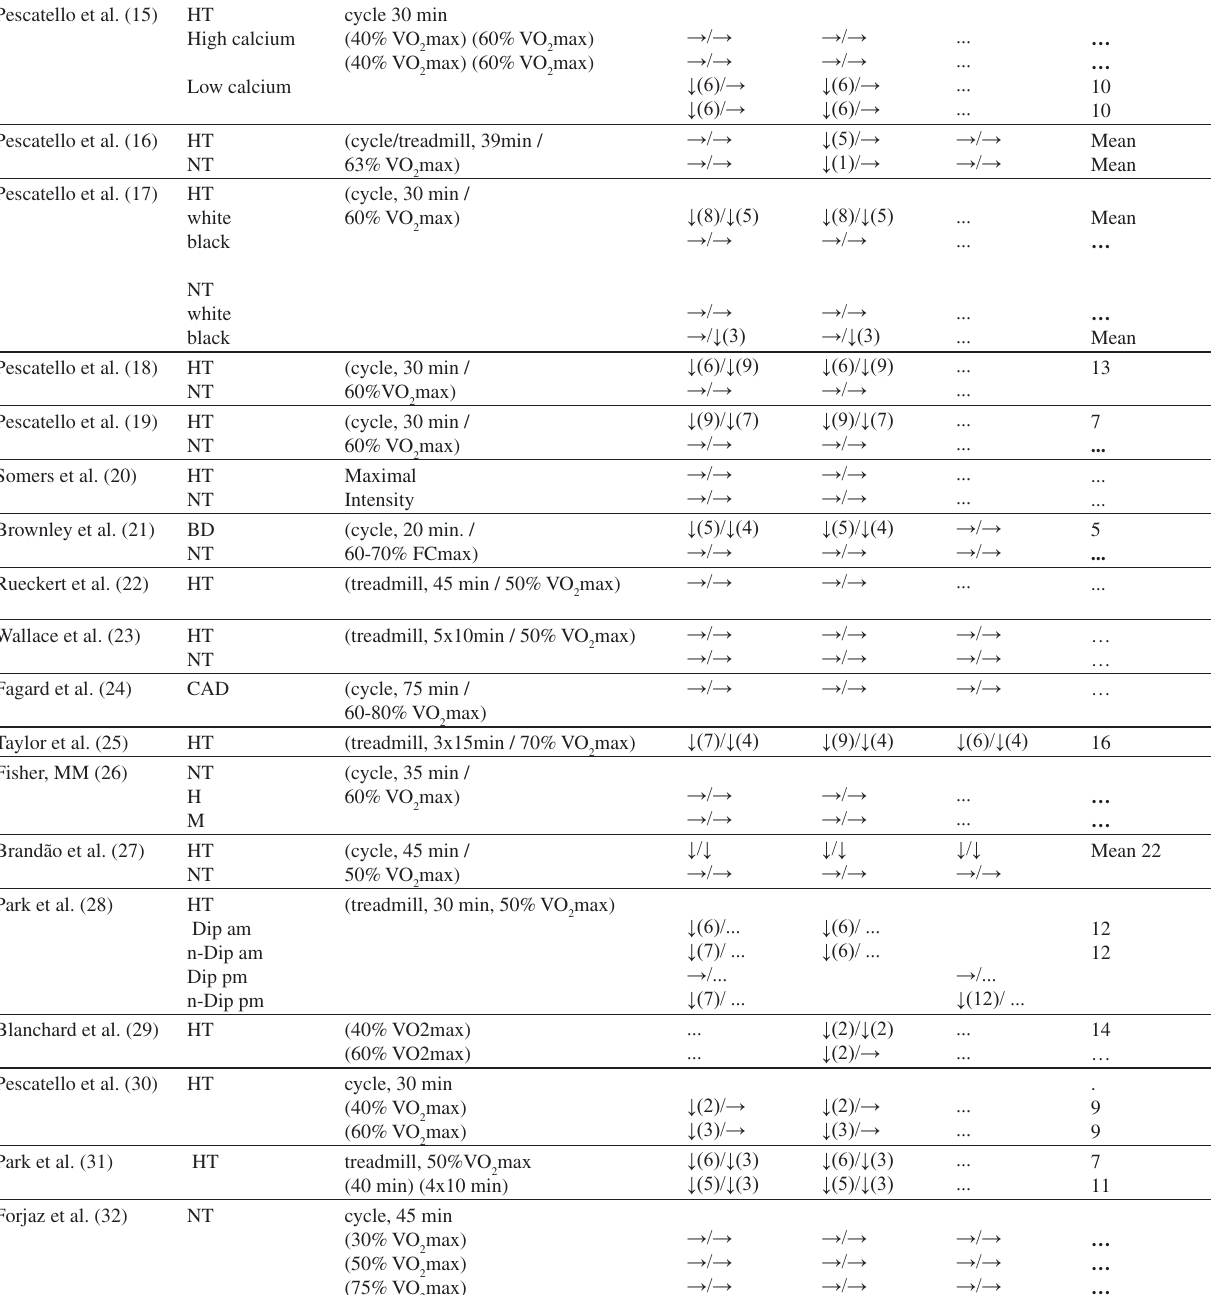
Table 1 - Effects of aerobic exercise on post-exercise ambulatory blood pressure